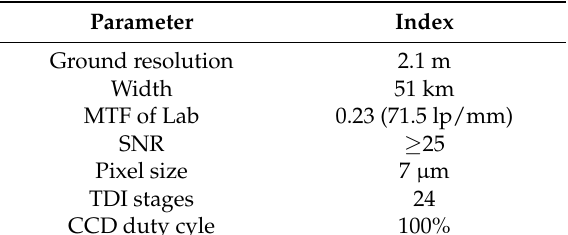
Table 1. Key technical parameters of the ZY-3 satellite nadir camera.